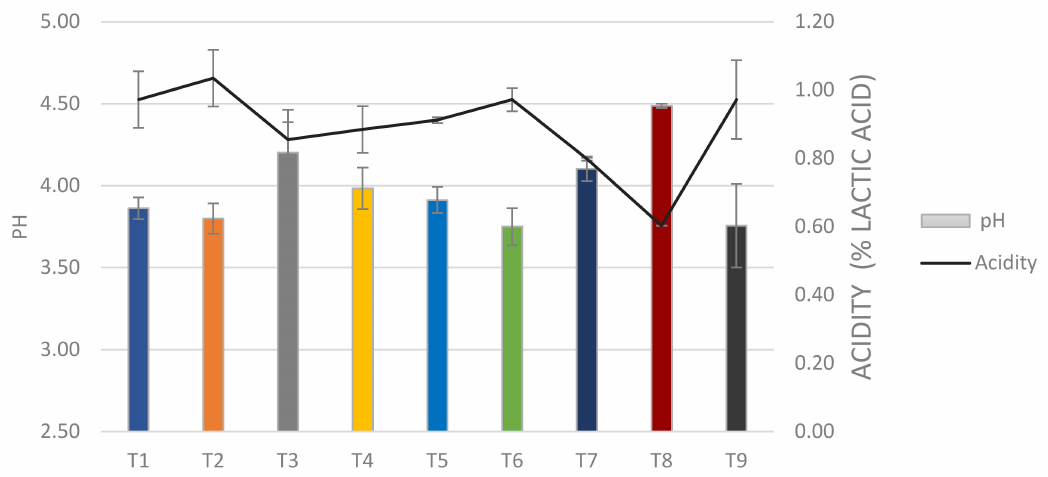
Figure 1. Variation of pH and acidity of the yogurt formulations at day 28 of storage.